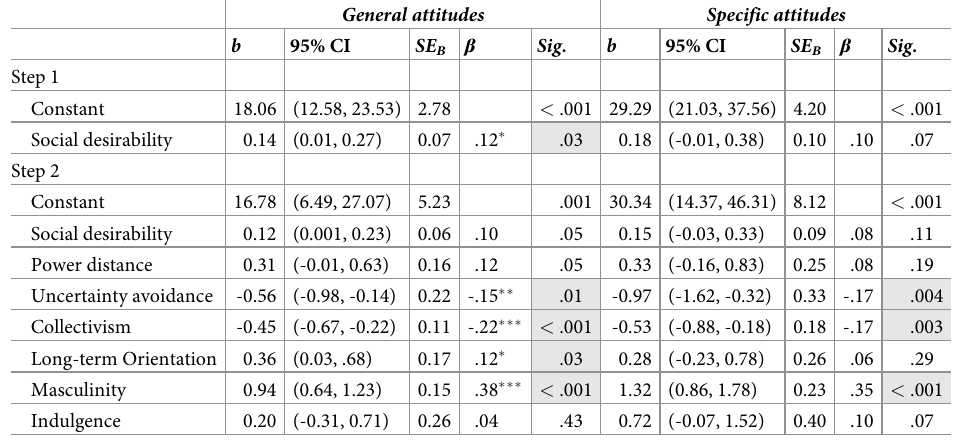
Table 13. Multiple regression for predicting attitudes to easing COVID-19 restrictions for cultural dimensions.